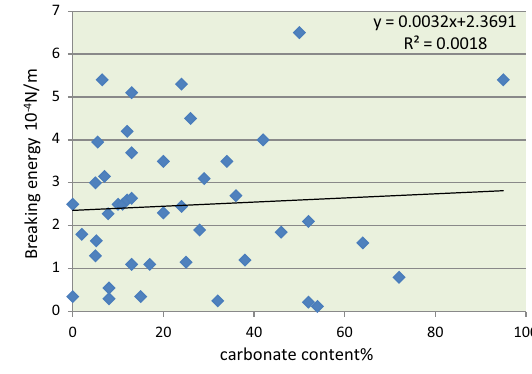
Fig. 9 Relationship between breaking energy and carbonate